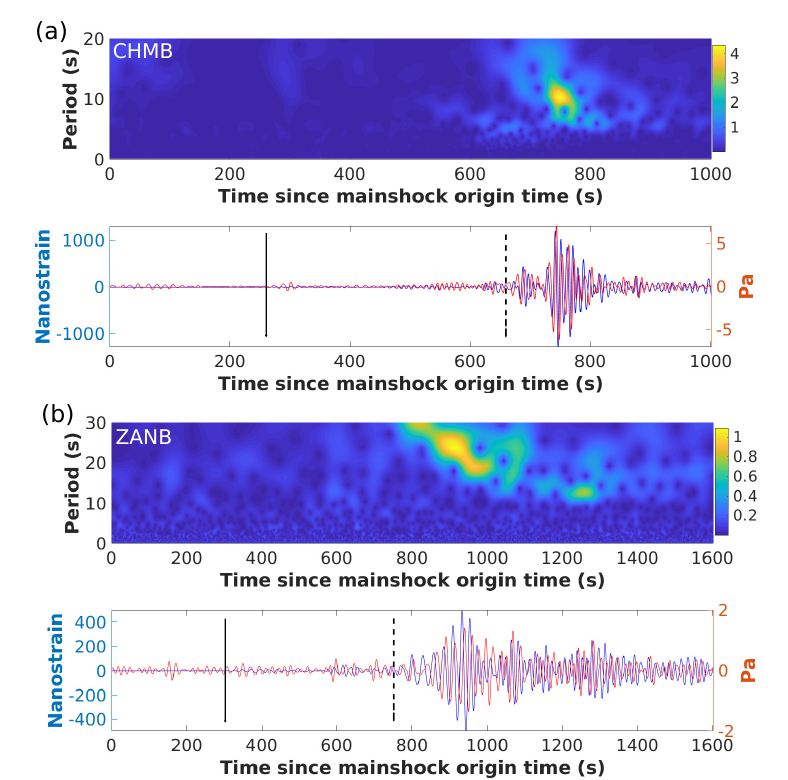
Figure 9. Example of detection of infrasound signals during teleseismic events using continuous wavelet transform analysis of the atmospheric pressure time series: ( a ) strain (blue curve) and infrasound (red curve) signals with a main period of 12 s recorded by CHMB during the 12 May 2008 M w 7.9 Sichuan earthquake and ( b ) signals with a main period of 20 s recorded by ZANB during the 11 March 2011 M w 9.1 Tohoku earthquake. Strain contraction and atmosphere overpressure are positive. Note that atmospheric overpressure follows contractional strain waves with a slight phase delay. Solid and dashed lines denote the P -wave and Rayleigh-wave arrival time at the station, respectively. “A. Canitano, Observation and theory of strain-infrasound coupling during ground- coupled infrasound generated by Rayleigh waves in the Longitudinal Valley (Taiwan), Bull.